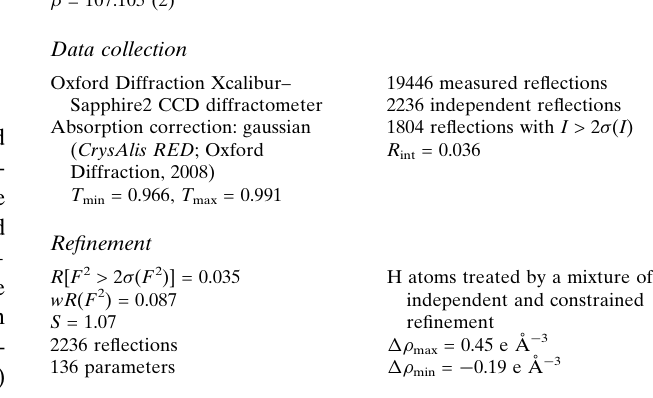
Data collection Oxford Diffraction Xcalibur– Sapphire2 CCD diffractometer Absorption correction: gaussian ( CrysAlis RED ; Oxford Diffraction, 2008) T min = 0.966, T max = 0.991